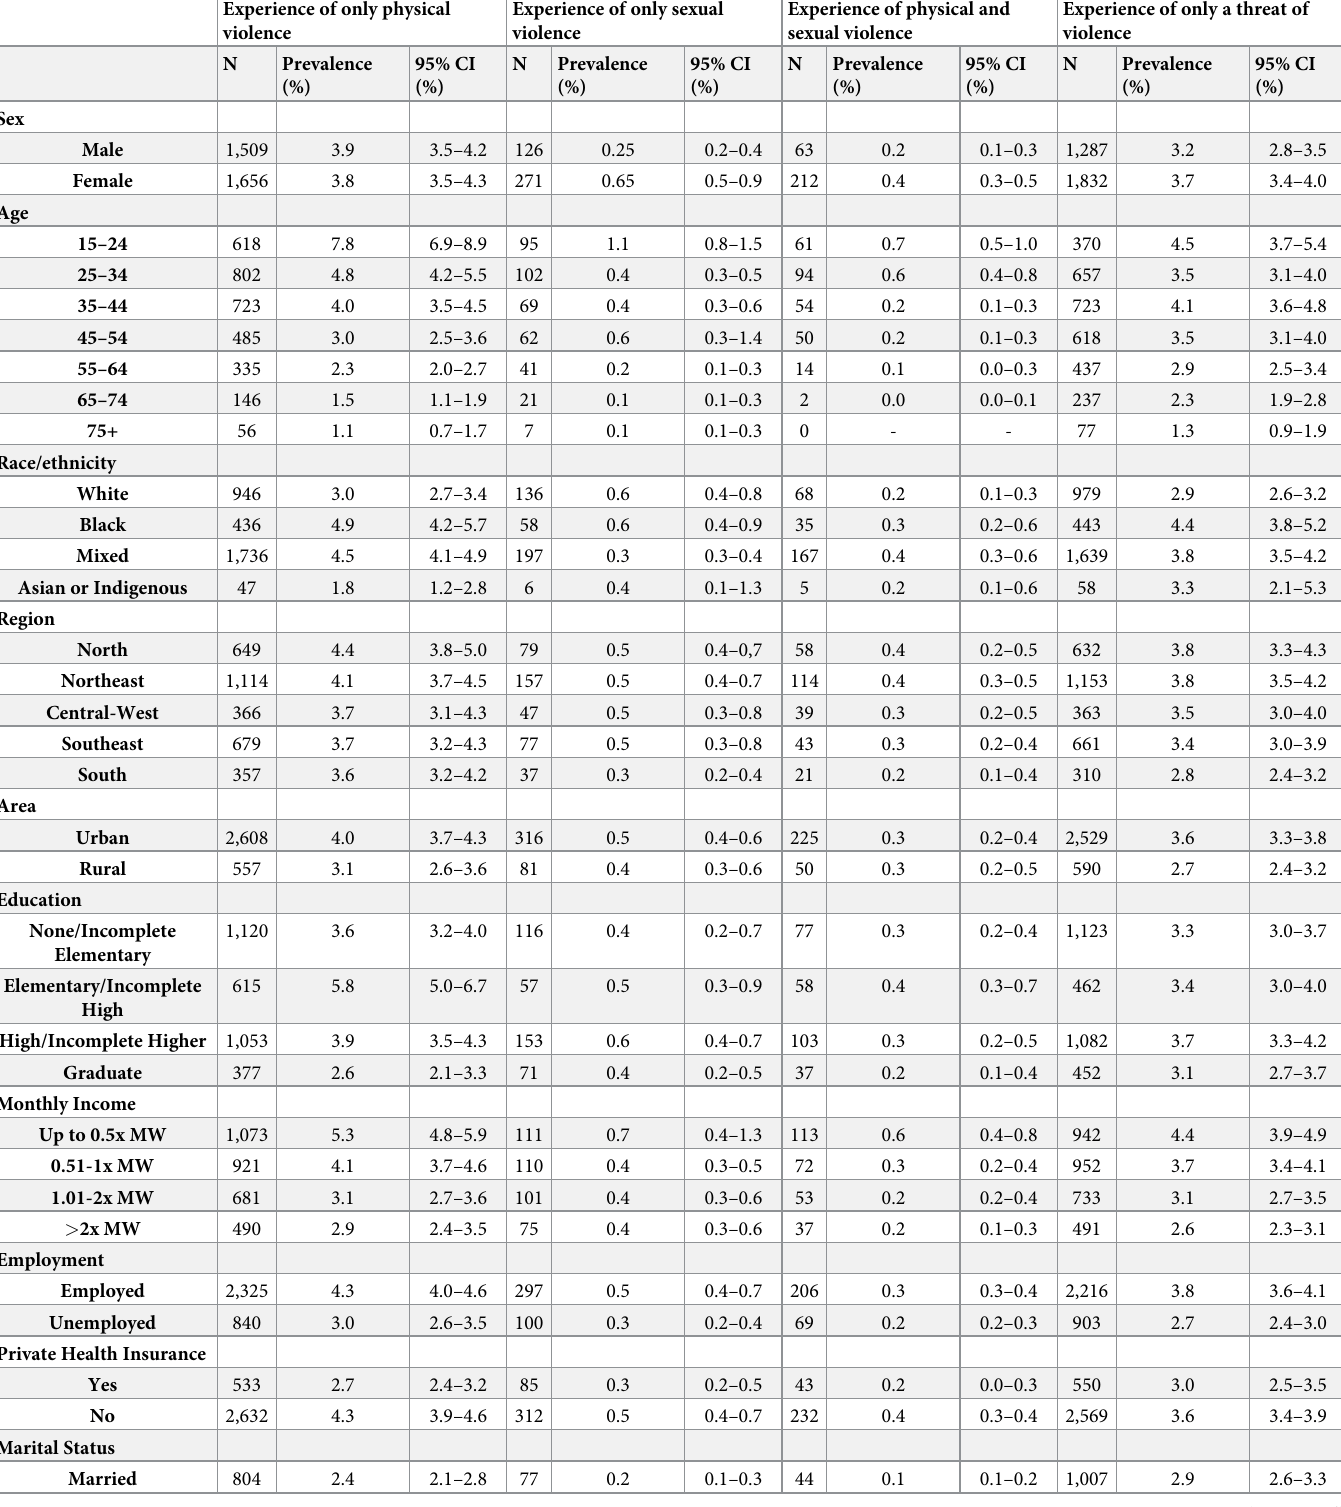
Table 2. Characteristics of survey respondents by types of violence